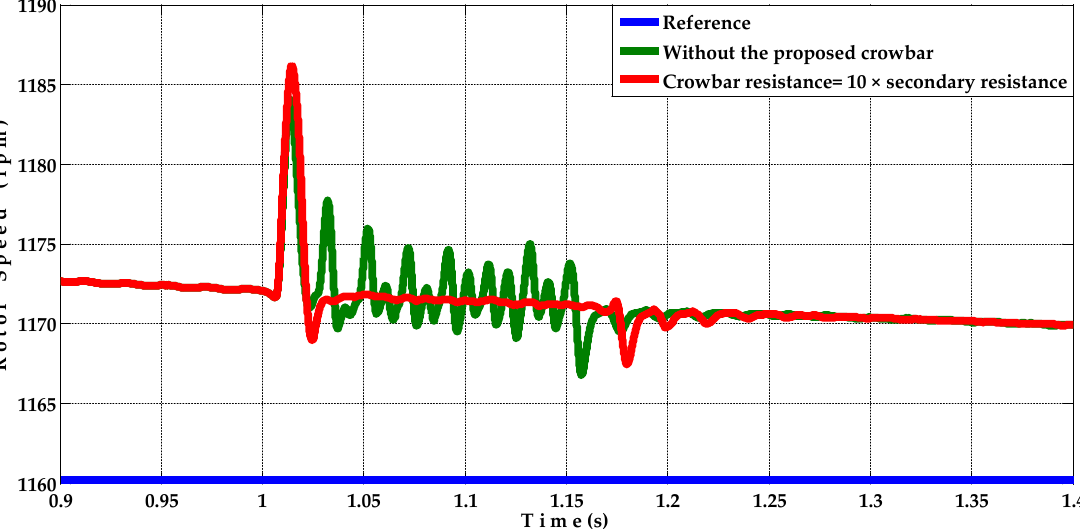
Figure 16. Rotor speed of BDFRG with and without the proposed crowbar under single line to ground fault occurrence.